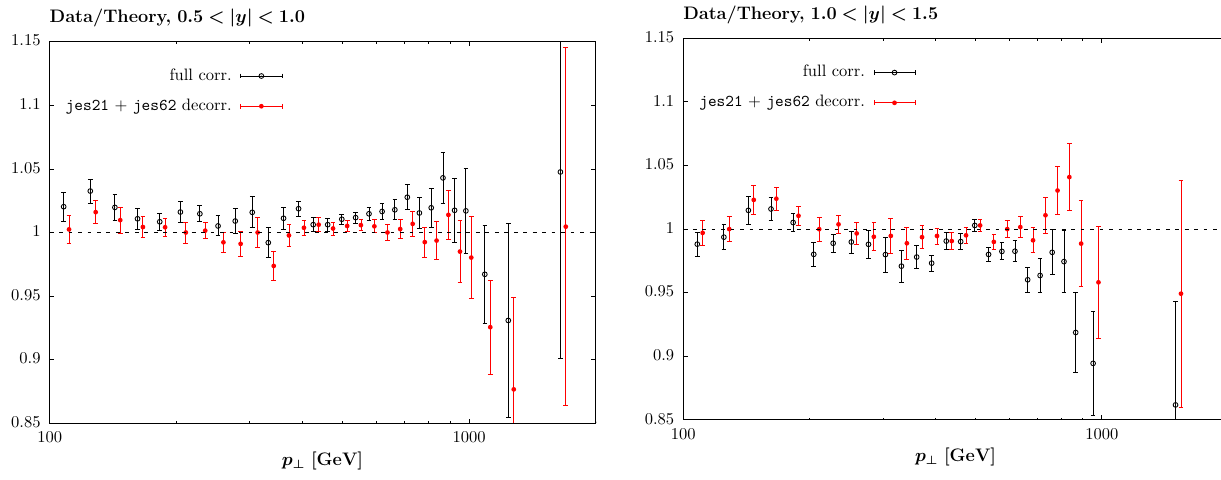
Fig. 4 Data/theory fit as in Fig. 2, for 0 . 5 < | y j | < 1 . 0 and 1 . 0 < | y j | < 1 . 5, with and without the labelled systematic errors decorrelated between jet rapidity bins Table 2 The χ 2 for the ATLAS ( N pts = 140) and CMS 7 TeV jet data ( N pts = 158) at NNLO. The quality of the description using the base- line set is shown, while the result of re-fitting to the single jet data set is